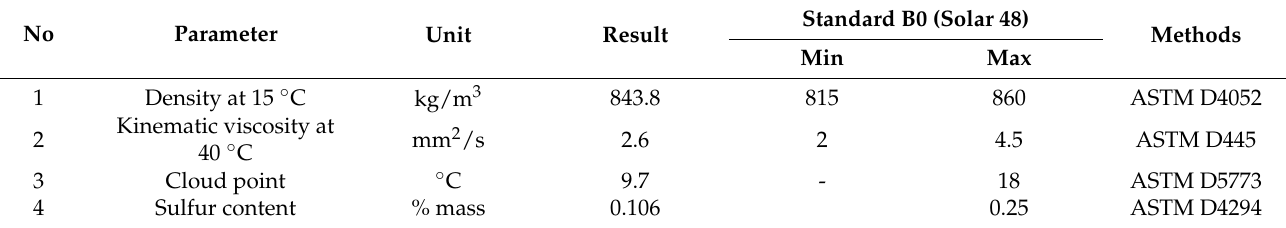
Table 4. Petrodiesel fuel (B0) specification and quality.